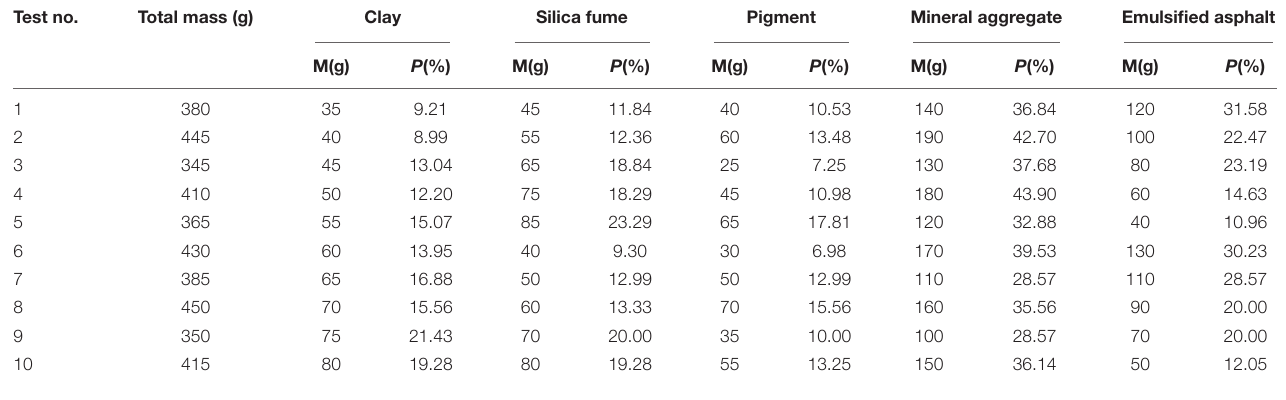
TABLE 6 | Uniform design test